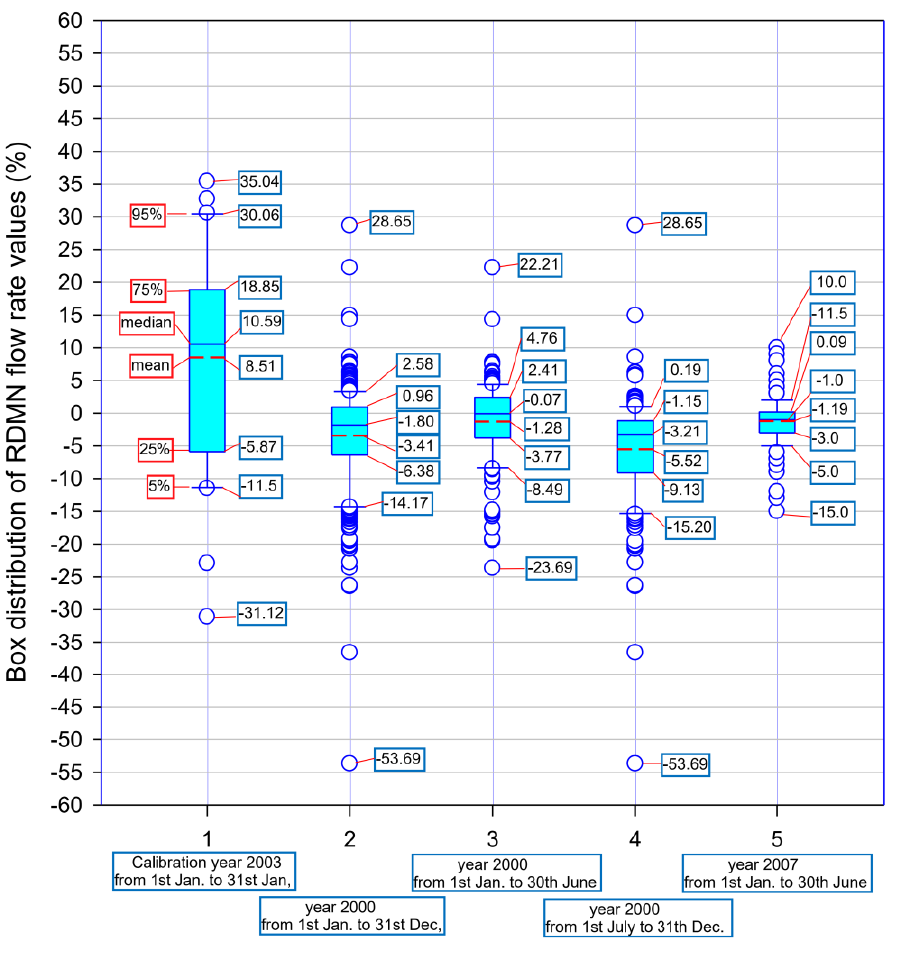
Figure 10. Box plot distributions of RDMN (%) for each selected time periods.